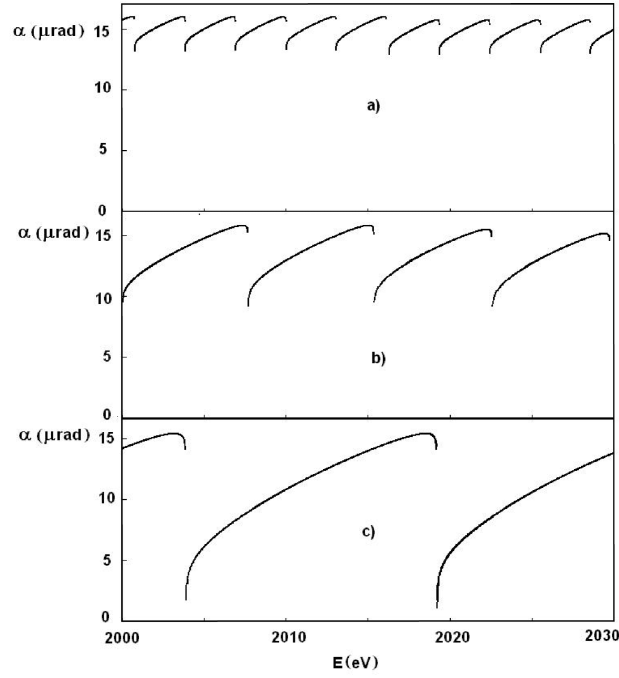
FIG. 3. The angle of volume reflection as a function of the transversal energy for the values of radius equal to 25 m (a), 10 m (b), and 5 m (c),